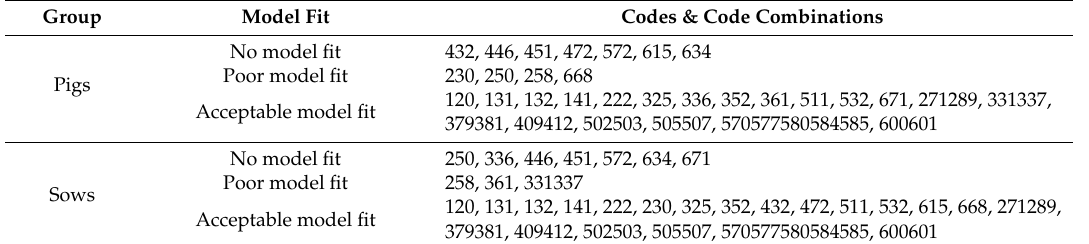
Table 5. Selected codes resulting in lack of variance partition estimates due to no model fit (too few positive observations), poor model fit and acceptable model fit for data on pigs and sows.